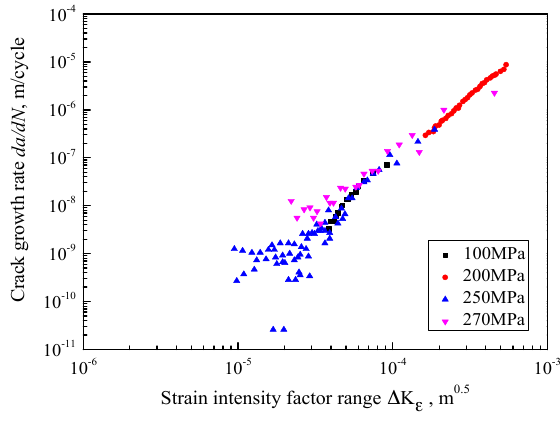
Figure 4. Crack growth rate vs. strain intensity factor range.